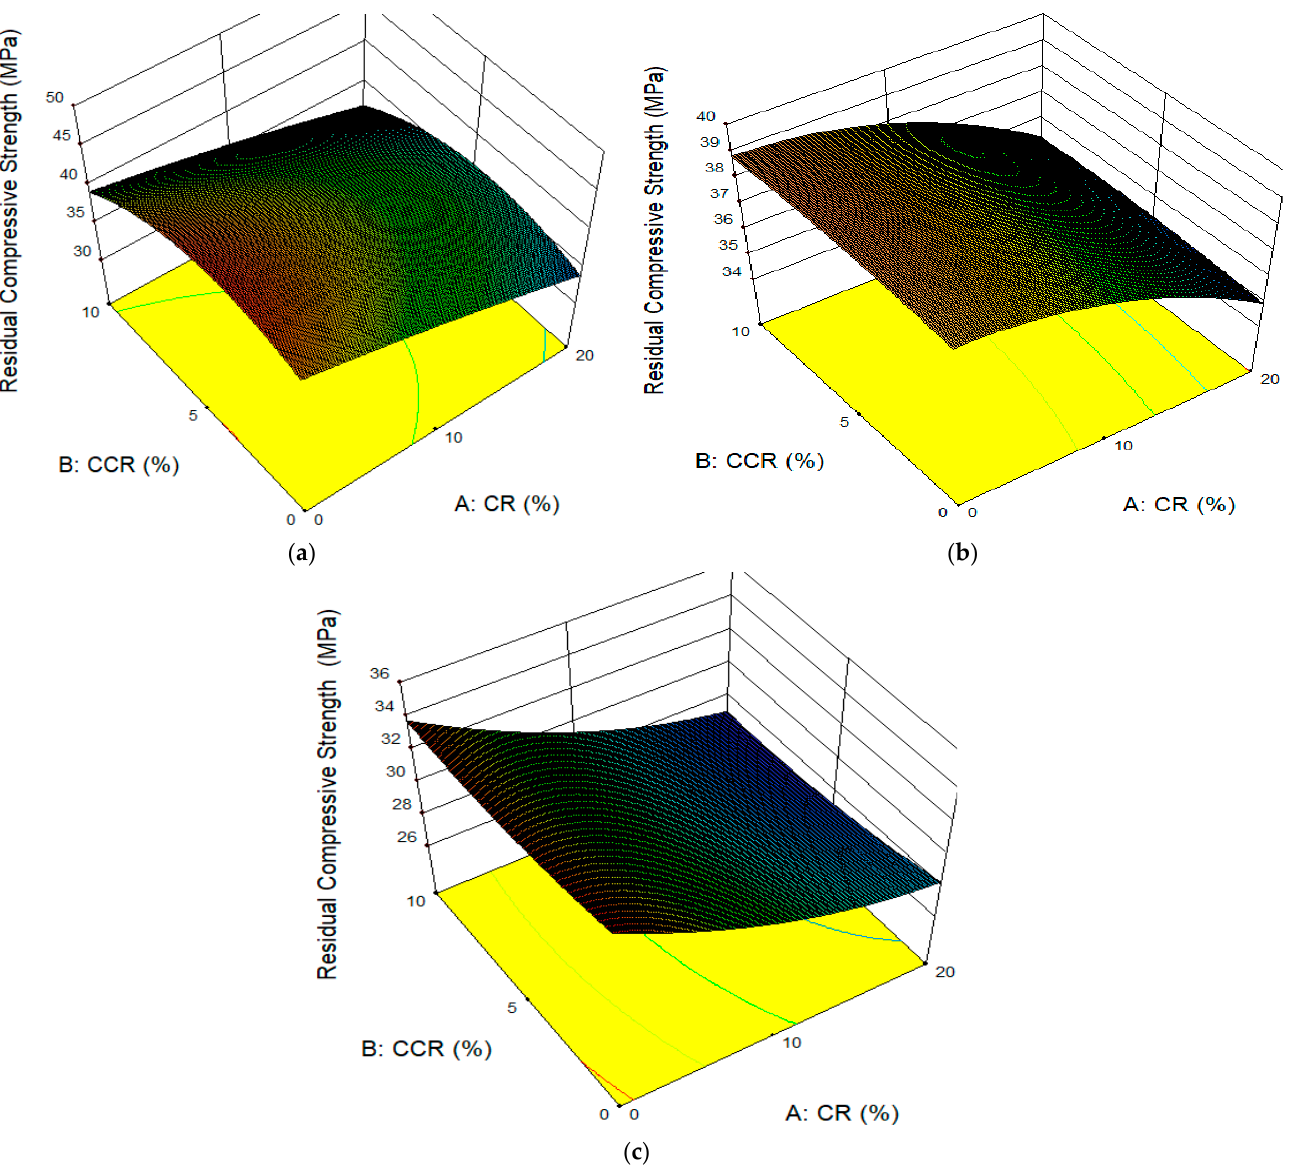
Figure 6. 3D response surface plot for residual compressive strength models for ( a ) Control Tem- perature (27 °C), ( b ) 200 °C, and ( c ) 400 °C. ture (27 ◦ C), ( b ) 200 ◦ C, and ( c ) 400 ◦